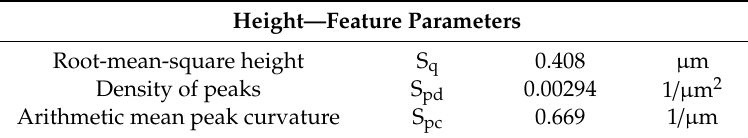
Table 1. Surface parameters for the gear teeth.